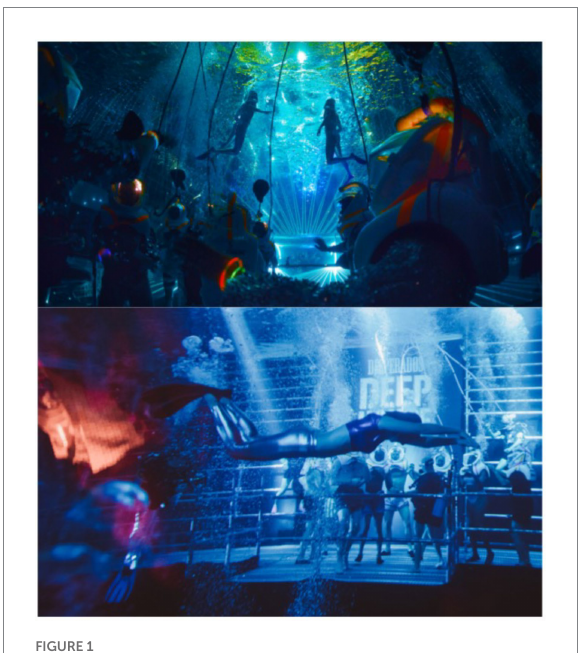
FIGURE 1 Images of the underwater nightclub